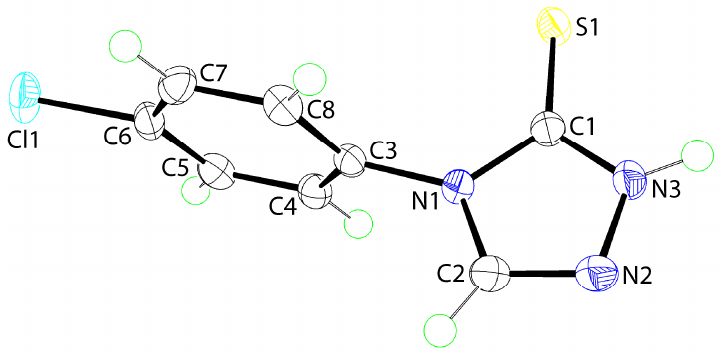
Figure 1. The molecular structure of 1 showing atom labeling and displacement ellipsoids at the 70% probability level. Selected geometric parameters: C1-S1 = 1.6840(14) Å, N2-N3 = 1.3778(16) Å, C1-N1 = 1.3726(18) Å, C1-N3 = 1.3403(18) Å, C2-N1 = 1.3721(18) Å, and C2-N2 = 1.2950(19) Å; S1-C1-N1 =